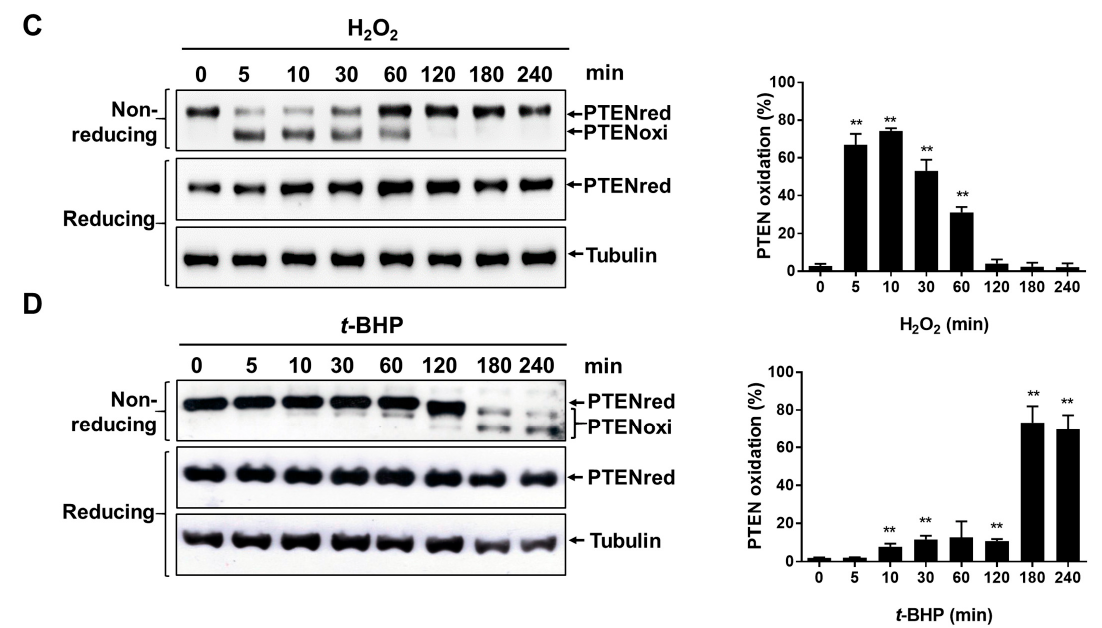
Figure 2. Effects of t -BHP and H 2 O 2 on redox state of PTEN in HeLa cells. Hela cells were incubated either with the indicated concentrations of H 2 O 2 ( A ) or t -BHP ( B ) for 30 min or incubated for the indicated times either with 1 mM H 2 O 2 ( C ) or 1 mM t-BHP ( D ). After treatment with 1 mg/mL of catalase for 5 min, cellular protein extracts were then alkylated with 20 mM NEM and subjected to non-reducing or reducing SDS-PAGE followed by Western blot analysis with antibodies to PTEN. Tubulin levels were used as a loading control. All blot data are representative of at least three separate experiments. The intensity of PTEN bands were quantitated with ImageJ software (ImageJ 1.50i, National institutes of Health, Bethesda, MD, USA), ** p < 0.05 as compared to